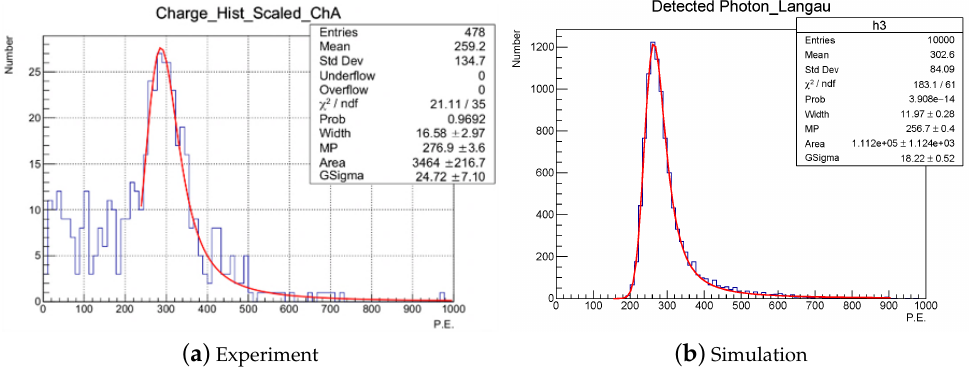
Figure 9. The MIP response of a scintillating glass tile: ( a ) cosmic ray test and ( b ) optical